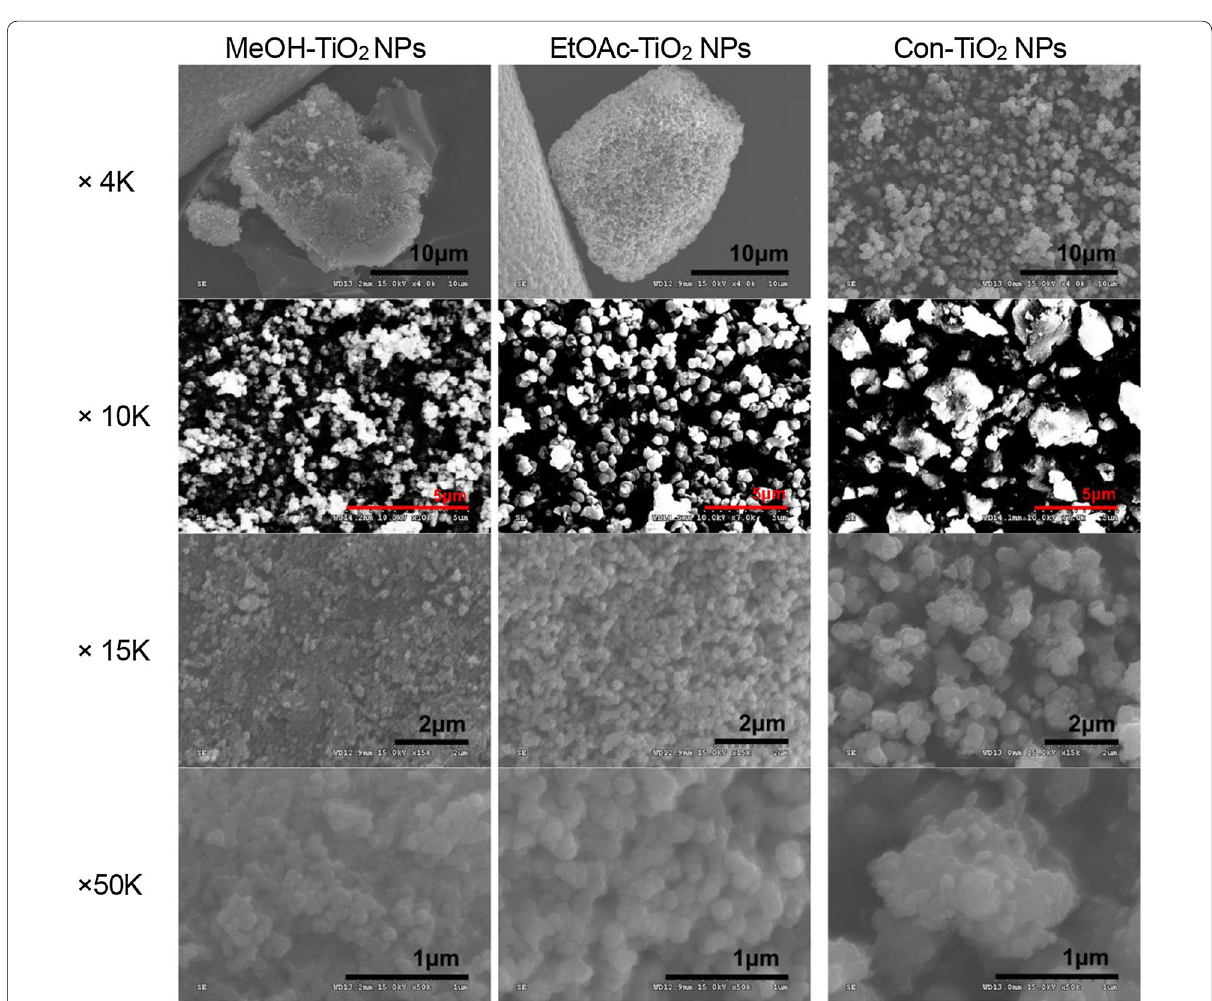
Fig. 2 FE‑SEM images. The left, middle and right columns represent MeOH‑TiO 2 NPs, EtOAc‑TiO 2 NPs and Con‑TiO 2 NPs,